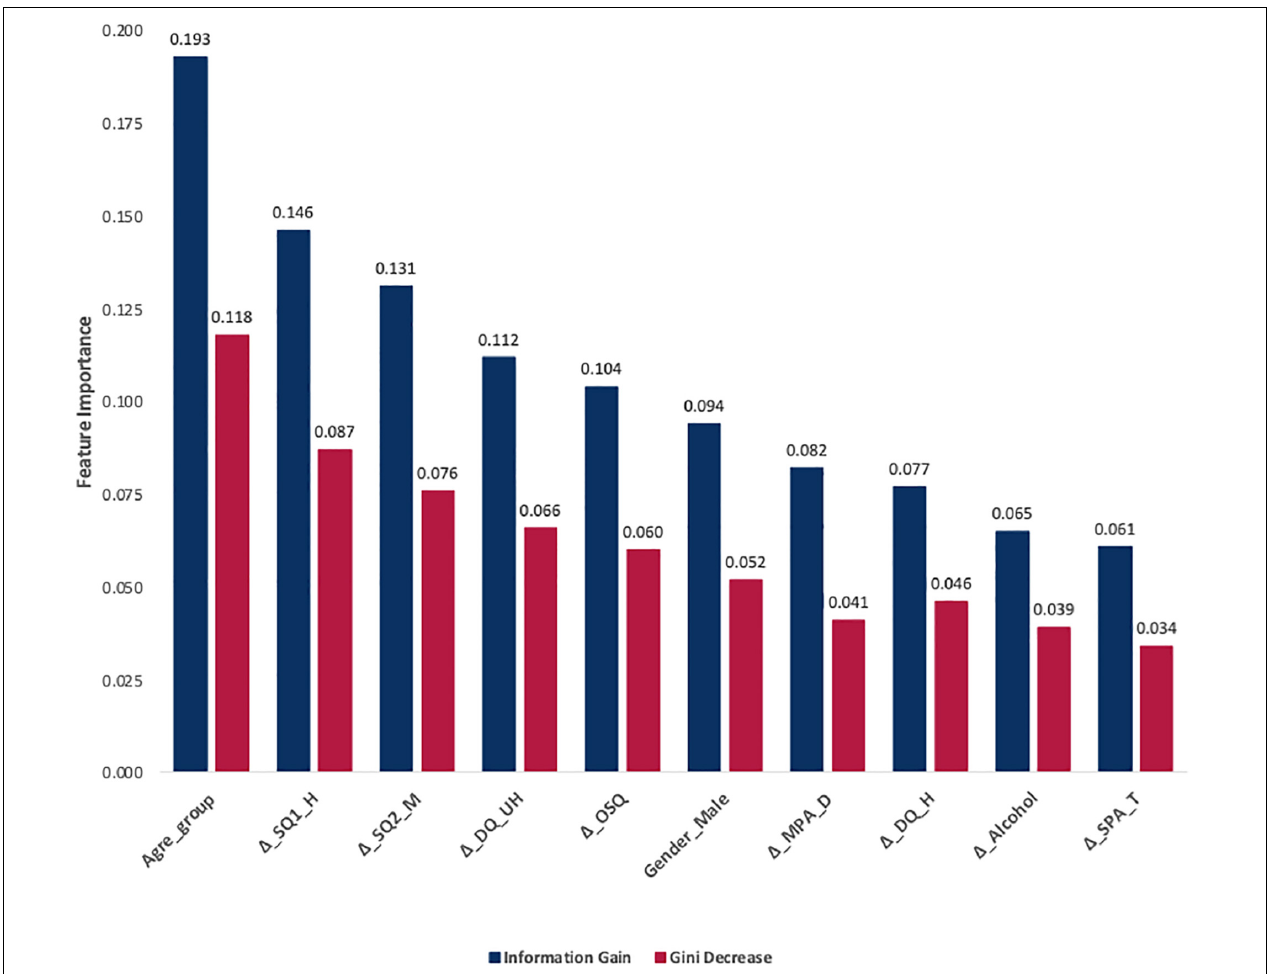
FIGURE 4 | Rankings of feature importance of the included behavioral and demographic correlates. Navy blue represents the ranking based on feature importance scores using Information Gain values. Glory red denotes the ranking based on feature importance scores based on Gini Decrease